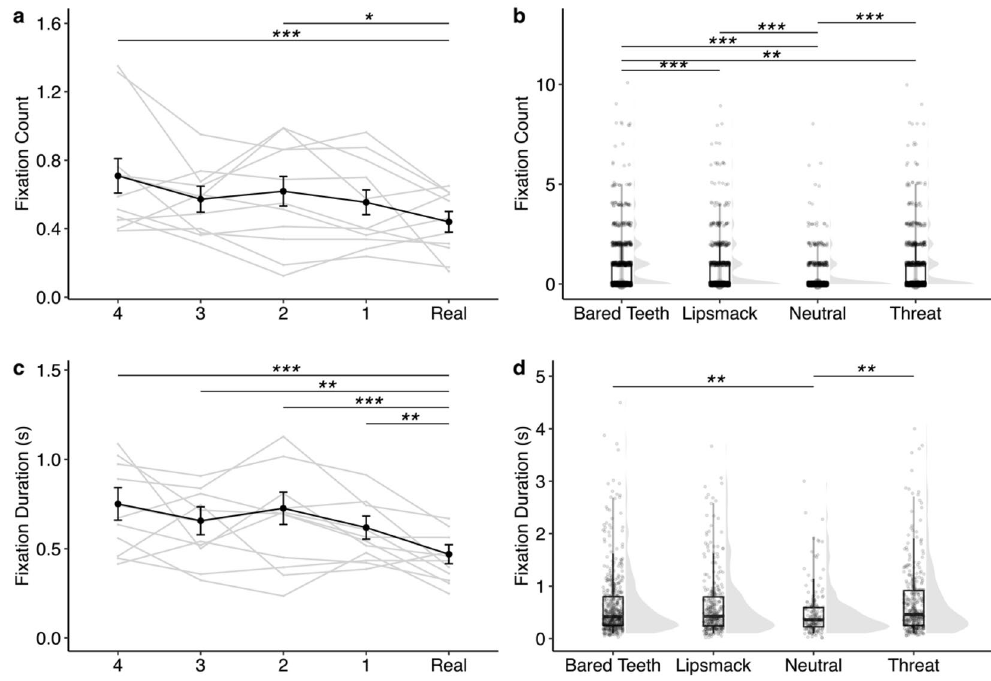
Figure 5. Visual attention directed toward the mouth AOI of the face stimuli. Fixation count data are in top panels and fixation duration data in bottom panels. In plots on the left ( a , c ), gray lines represent average behavior of a given subject pooled across facial behaviors and the black line represents average behavior across all subjects. In plots on the right ( b , d ), individual data points are overlaid on boxplots with violin plot density functions on the right for each facial behavior pooled across face realness levels. ( a ) Subjects looked less frequently at the mouth of Real images than Face 4 ( z = 4.25, p < 0.001) or Face 2 ( z = 3.16, p = 0.014). Data are summarized across 832 individual trials per face realness level. ( b ) Subjects looked at the mouth fewer times when the stimulus depicted a neutral facial behavior compared to any other facial behavior (neutral vs bared teeth: z = 13.77, p < 0.001; neutral vs lipsmack: z = 9.30, p < 0.001; neutral vs threat: z = − 10.46, p < 0.001) and more times when the facial behavior depicted was bared teeth compared to all other facial behaviors (bared teeth vs lipsmack: z = 6.06, p < 0.001; bared teeth vs threat: z = 3.65, p = 0.002). Data represent 1040 trials per facial behavior. ( c ) Subjects fixated on the mouth for less time when the image was real compared to any manipulated image (Face 1: z = − 3.00, p = 0.023; Face 2: z = − 4.96, p < 0.001; Face 3: z = − 3.75, p = 0.002; Face 4: z = − 5.16, p < 0.001). Data are averaged across 240–256 individual trials per level of face realness. ( d ) Subjects fixated on the mouth for less time when the facial behavior of the stimulus was neutral compared to either bared teeth ( z = − 3.38, p = 0.004) or threat ( z = 3.81, p = 0.001). Data represent 157–465 trials per facial behavior. * p < 0.05, ** p < 0.01, *** p < 0.001. Error bars represent mean ± 95% confidence